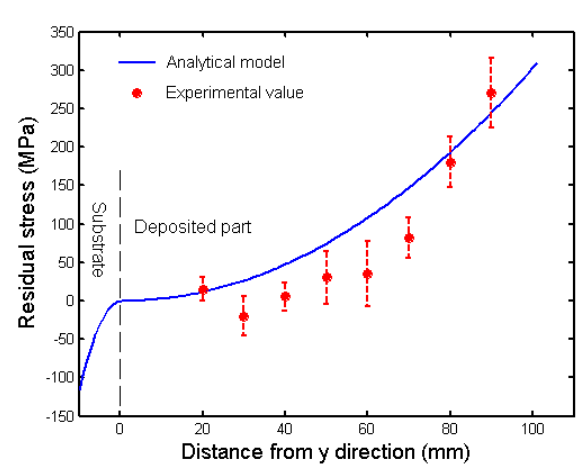
Figure 5. Stress comparison of analytical and experimental value along central line.